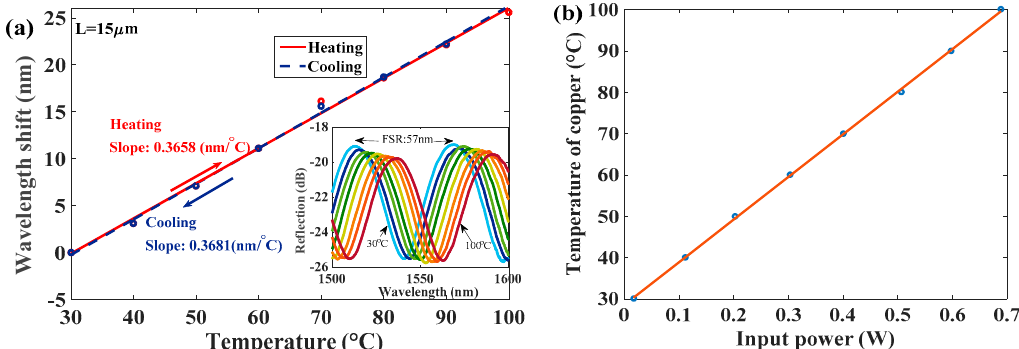
Figure 4. ( a ) Sensitivities of the proposed sensor to T during heating and cooling; inset is the corresponding spectrum; ( b ) T of the proposed heater corresponding to input power.